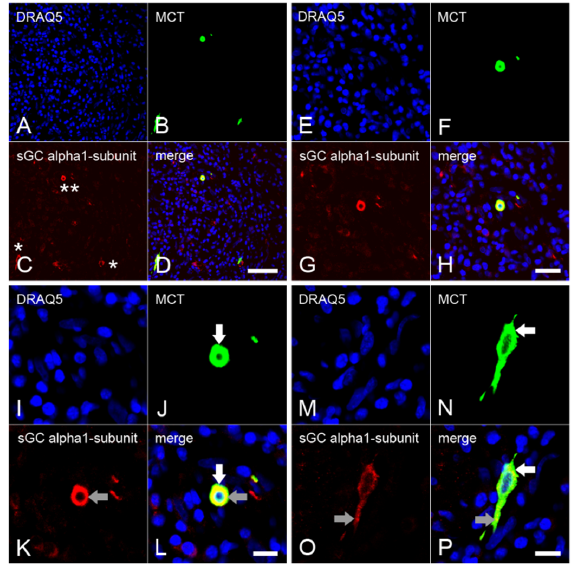
Figure 3. Colocalization of the α 1 subunit of sGC with MCT in mast cells in chronically inflamed human dental pulp. Numerous inflammatory cells with DRAQ5 nuclear staining are visible in the overview images of chronically inflamed human dental pulp ( A ). MCT ( B ) is colocalized with the sGC α 1 subunit ( C ) in some inflammatory cells with strong (( C ), two asterisks) and weak (( C ), one asterisk) staining intensities ( D ). Detailed images show the cytoplasmic subcellular colocalization of MCT with the sGC α 1 subunit at strong ( E – L ) and weak ( M – P ) immunostaining intensities in mast cells. In mast cells, the localizations of MCT ( J , L , N , P ) are shown with white arrows, while grey arrows show the α 1 subunit of sGC ( K , L , O , P ). Scale bars: A – D = 50 µm; E – H = 20 µm; I – P = 10 µm.